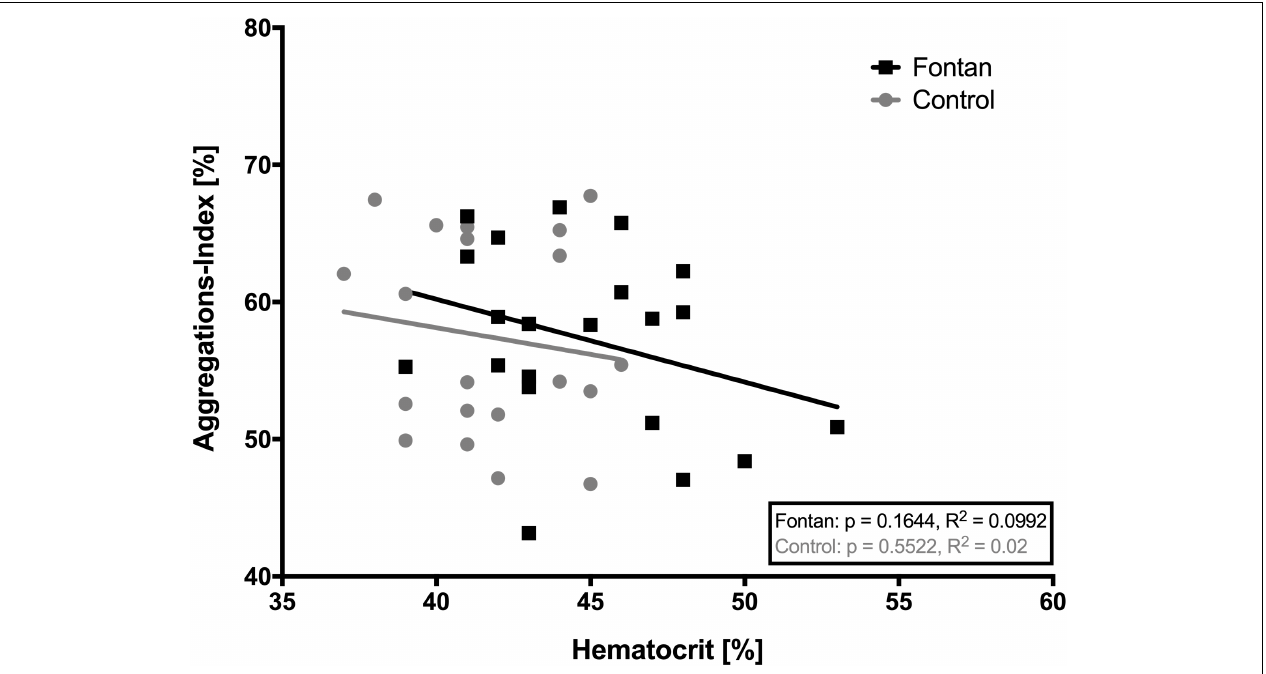
FIGURE 5 | Correlation of native hematocrit (hct) with aggregations-index (AI). No significant correlation was found in any group. This might indicate that AI in this study was not influenced by native hct.